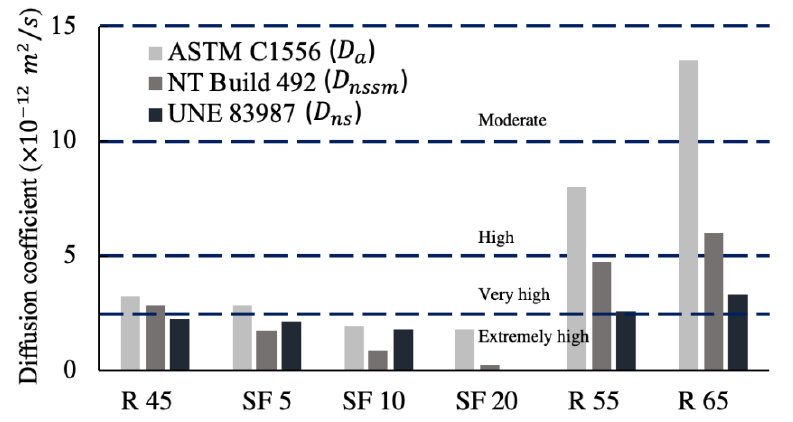
Figure 9. Panorama of the diffusion coefficients obtained through the three test methods.